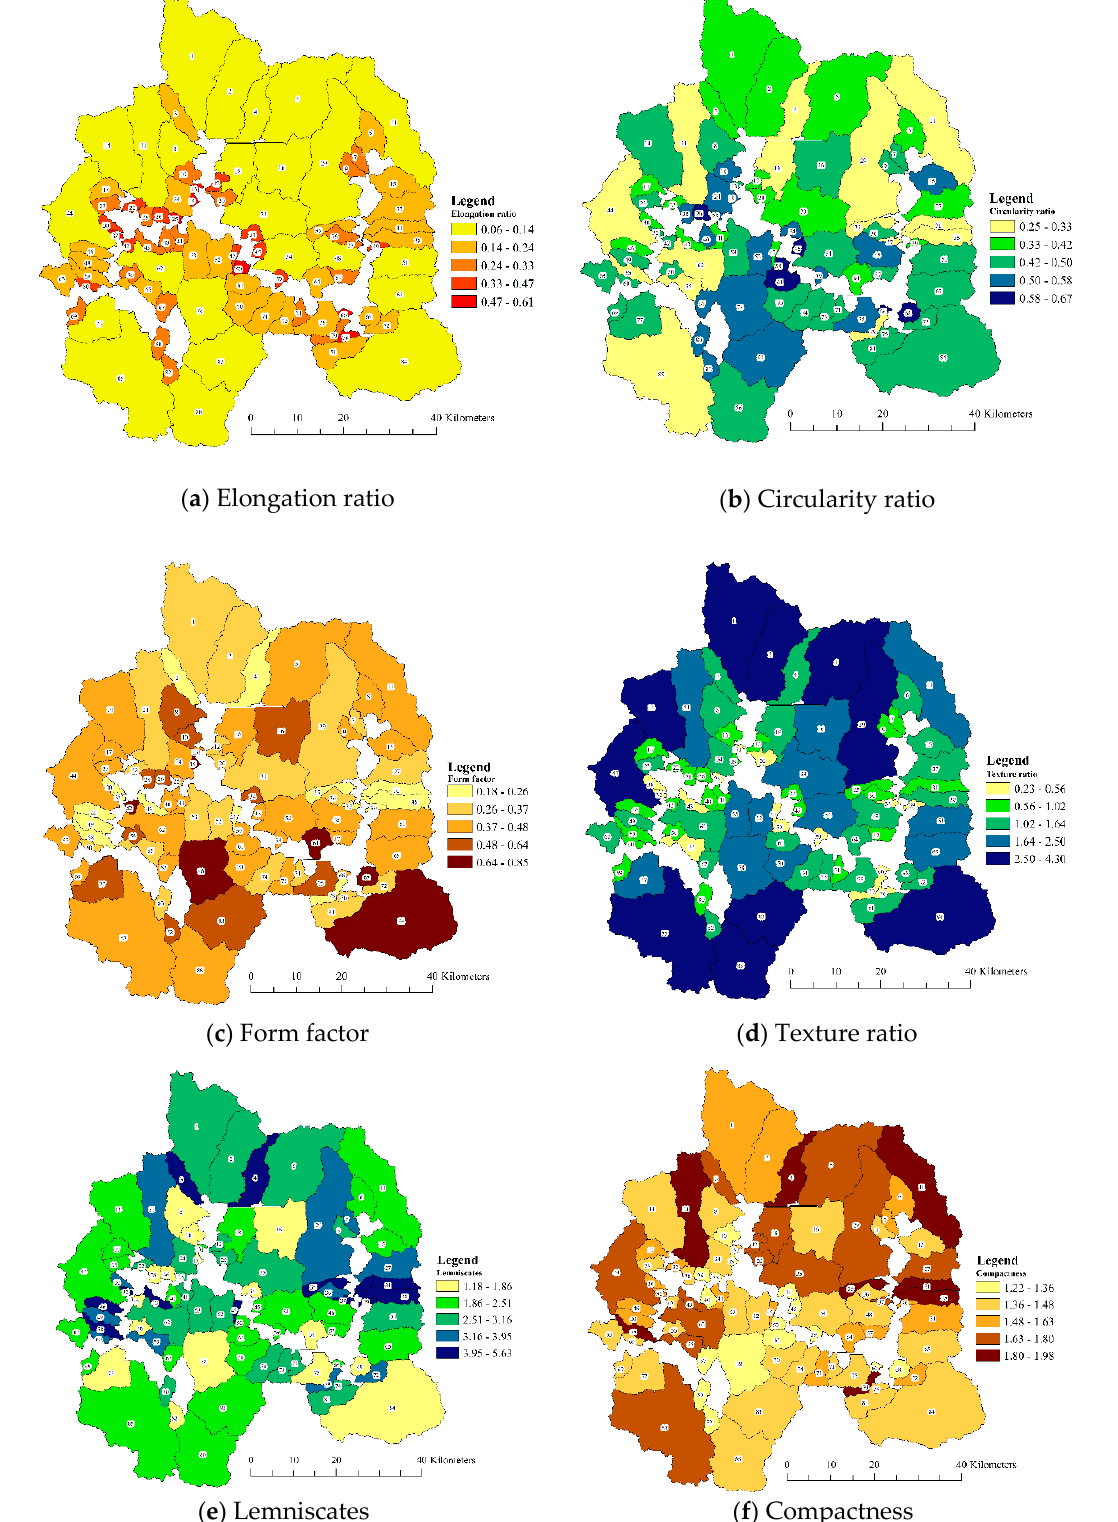
Figure 6. Areal features parameters ( a ) Elongation ratio; ( b ) Circularity ratio; ( c ) Form factor; ( d ) Texture ratio; ( e ) Lemniscates; and ( f ) Compactness.